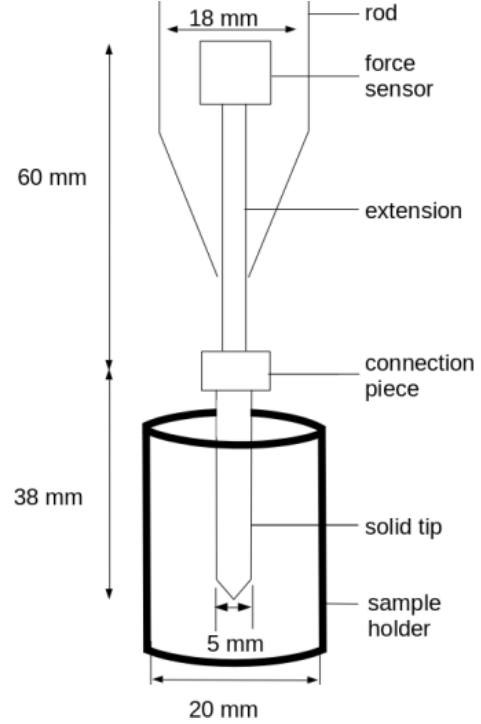
Figure 5. Setup of micro-cone penetration test (Peinke et al., 2020). The cone penetration tests (CPTs) were conducted by inserting a cylinder of diameter 5mm, with a conical tip of an apex angle of 60 ◦ , into the snow samples. The samples were placed in the cylin- der sample holder with a diameter of 20mm. The cone was inserted vertically at a constant speed of 20mms − 1 . The SMP force sen- sor (Kistler 9207) measures forces in the range of [0, 40]N with a resolution of 0.01N.